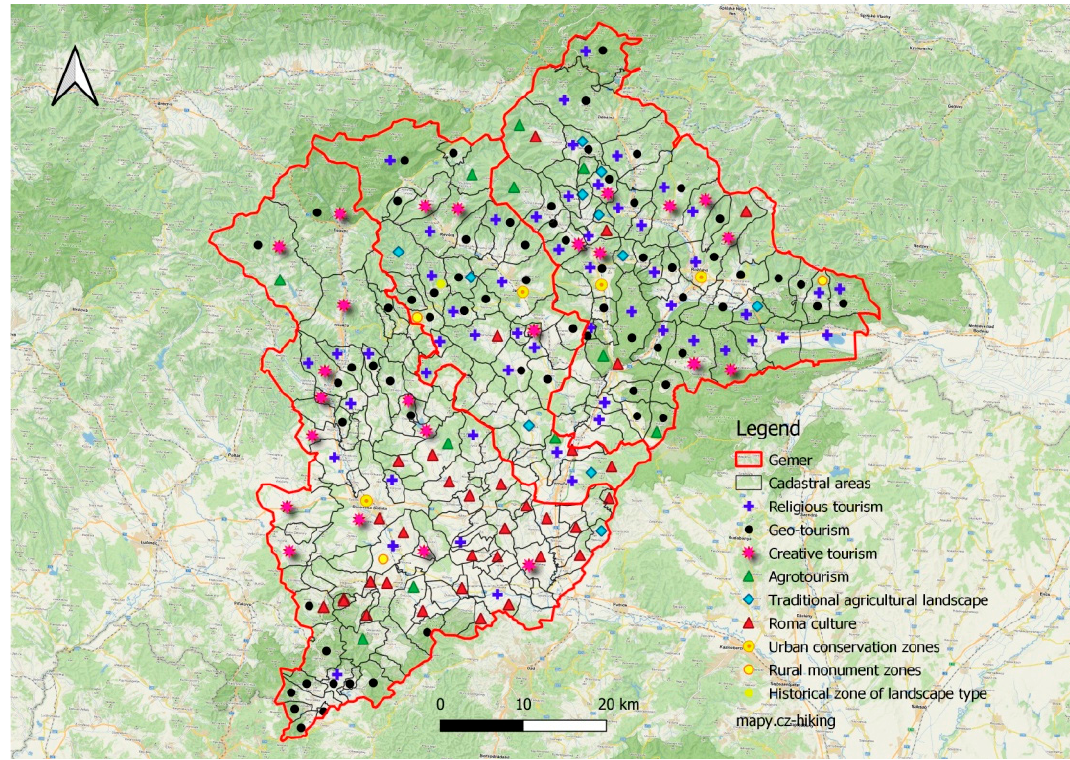
Figure 3. Map of tourism attractions in the Gemer region.